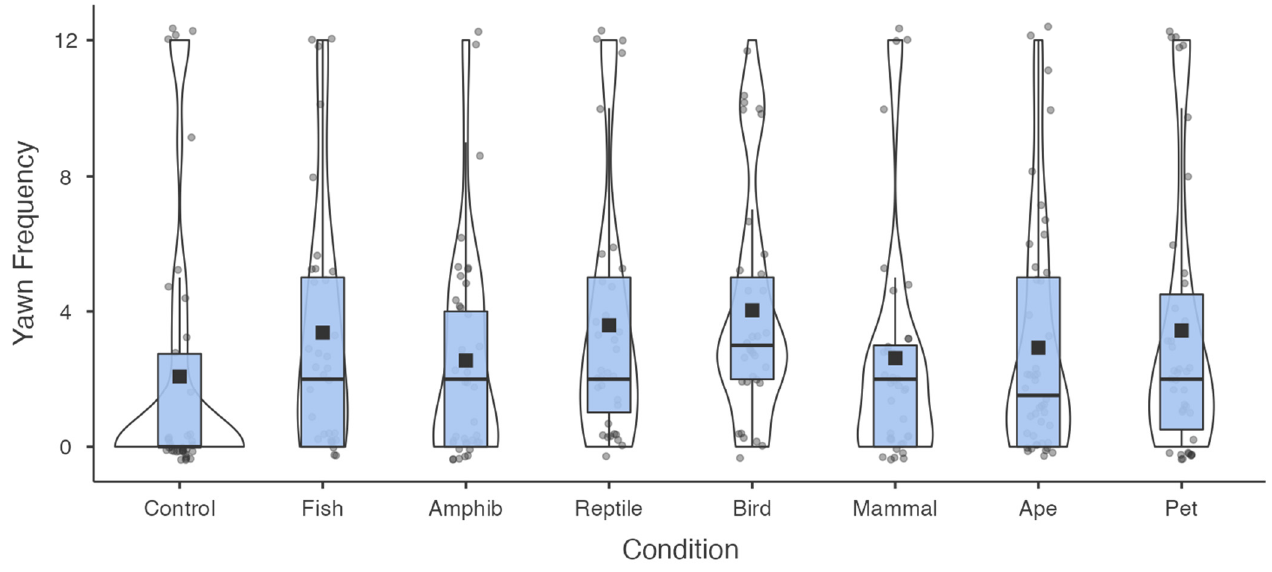
Figure 2. Box and violin plots depicting the frequency of contagious yawning across conditions. Box plots represent the median, interquartile ranges, and the whiskers extend 1.5 times the interquartile range for the upper and lower boundary, while the violin plots illustrate the distribution of yawn frequency. Observed responses (grey circles) and group means (black boxes) are also represented.